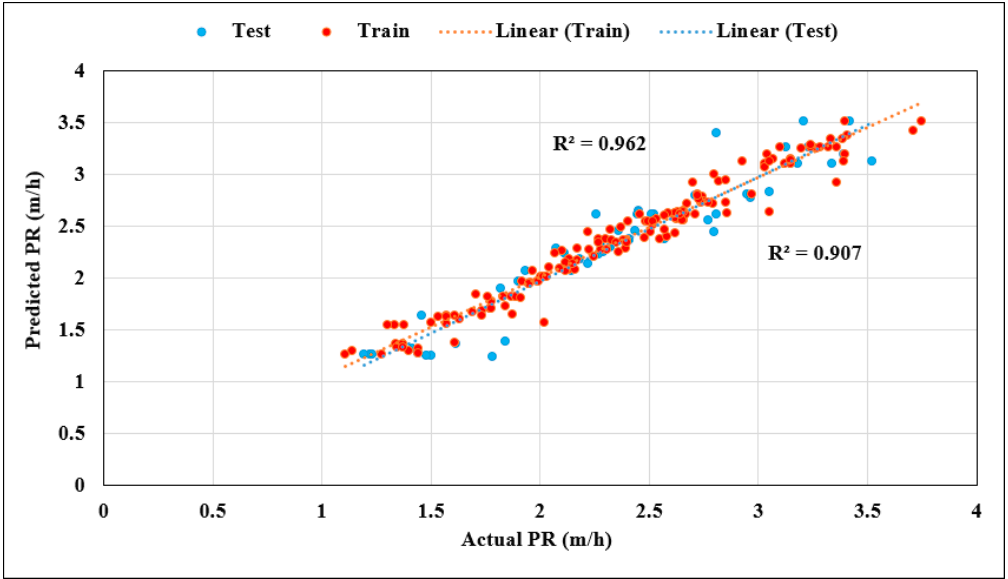
Figure 8. Testing and training results of the KNN model in estimating PR.